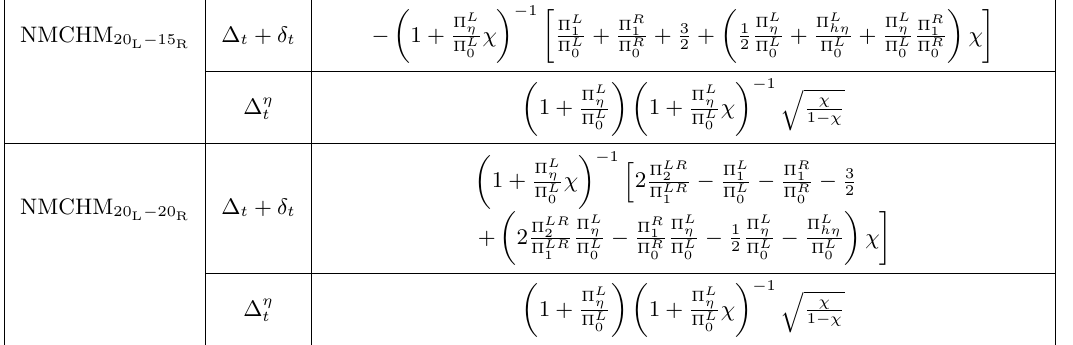
for di(cid:11)erent representations of SO(6) in which the top t